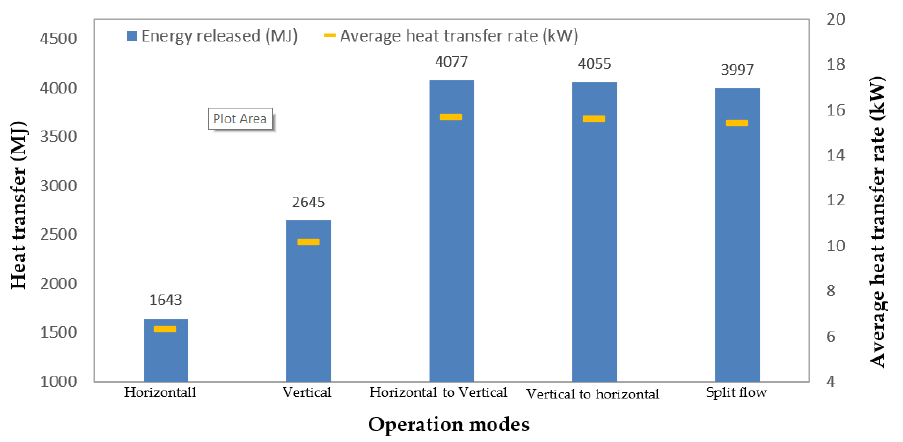
Figure8. Energyreleasedin3daysandaverageheattransferrateoftheGHEundercontinuousoperation Figure 8. Energy released in 3 days and average heat transfer rate of the GHE under continuous condition in Adelaide (where the inlet fluid temperature = 50 ◦ C, fluid mass flow rate = 0.6 kg / s, length operation condition in Adelaide (where the inlet fluid temperature = 50 °C, fluid mass flow rate = 0.6 of horizontal GHE = 200 m, length of vertical GHE = 200 kg/s, length of horizontal GHE = 200 m, length of vertical GHE = 200 m).